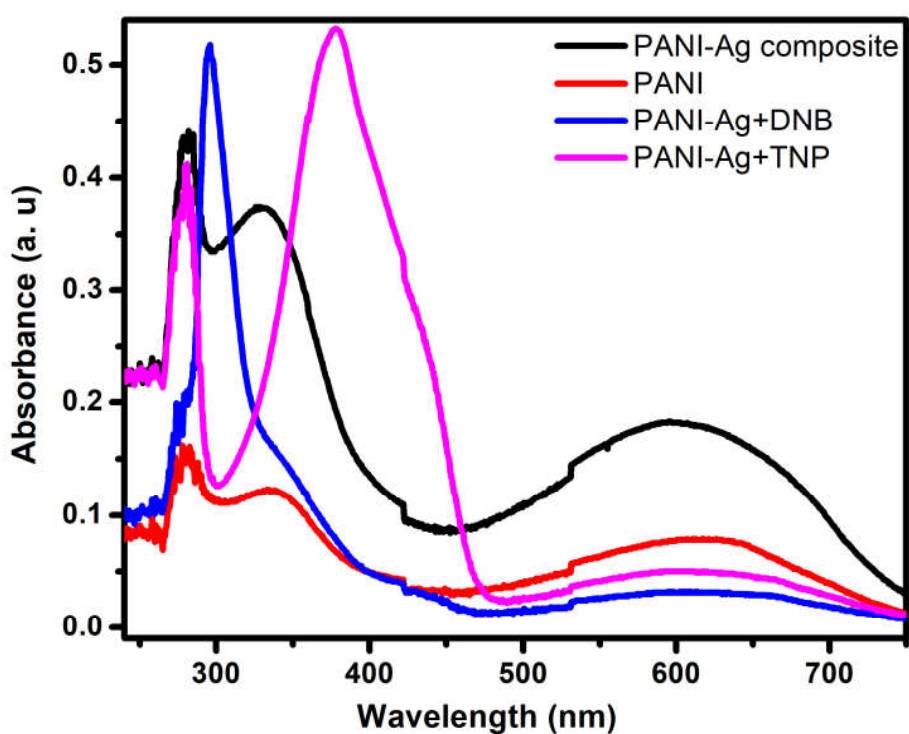
Figure 8. UV-vis spectra of PANI and the PANI-Ag composite.